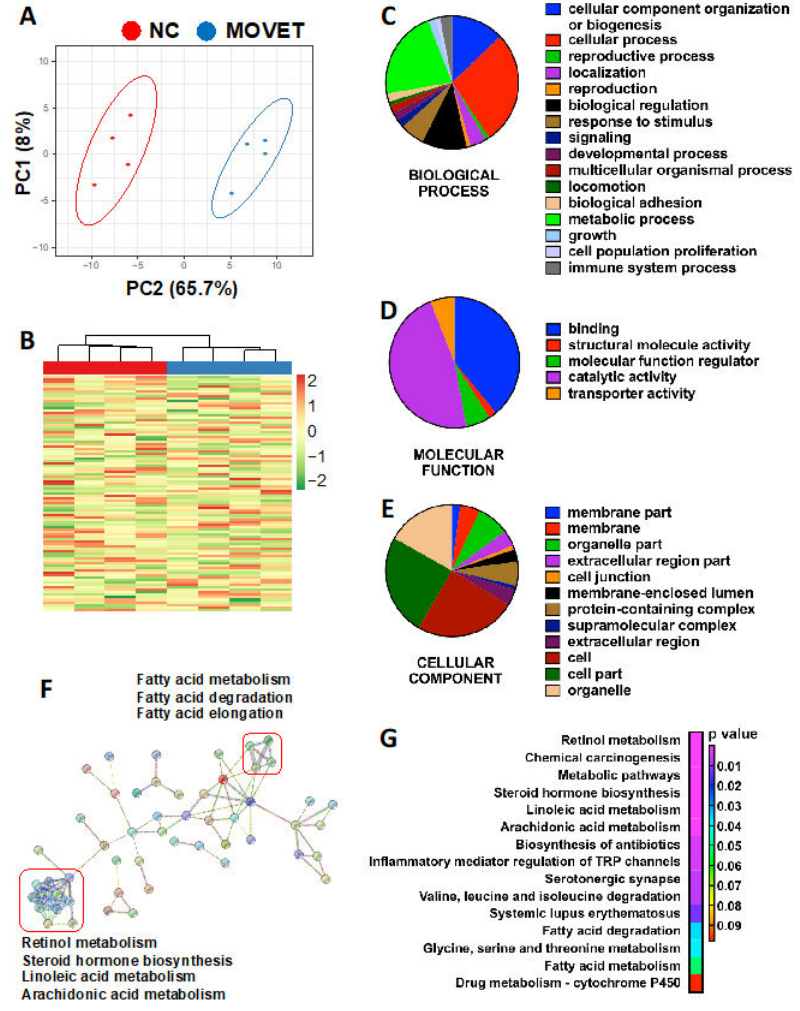
Figure 2. Protein profile changes in the liver of F3 generation animals derived from early embryos exposed to the combination of multiple ovulations, vitrification and embryo transfer (MOVET) and naturally conceived (NC) were compared. ( A ) Principal components analysis of the differentially expressed proteins (DEPs). ( B ) Heat map clustering of the DEPs. ( C – E ) Pie charts representing the DEPs distribution according to their biological process, molecular function, and cellular component. ( F ) Protein–protein interaction network of DEPs. Not interconnected DEPs were excluded. ( G ) KEGG analysis for the